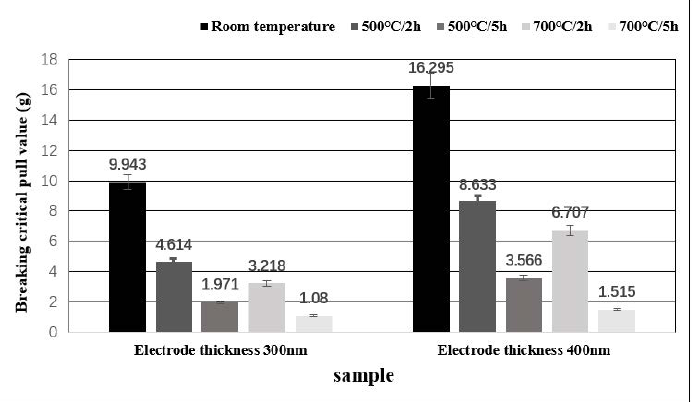
Figure 6. Histogram depicting the critical failure tension of the initial wire bonded samples at room temperature and the heat-treated bonded samples.